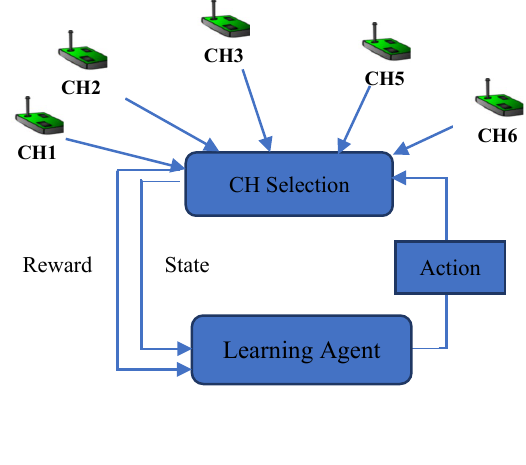
Figure 7. RL Learning